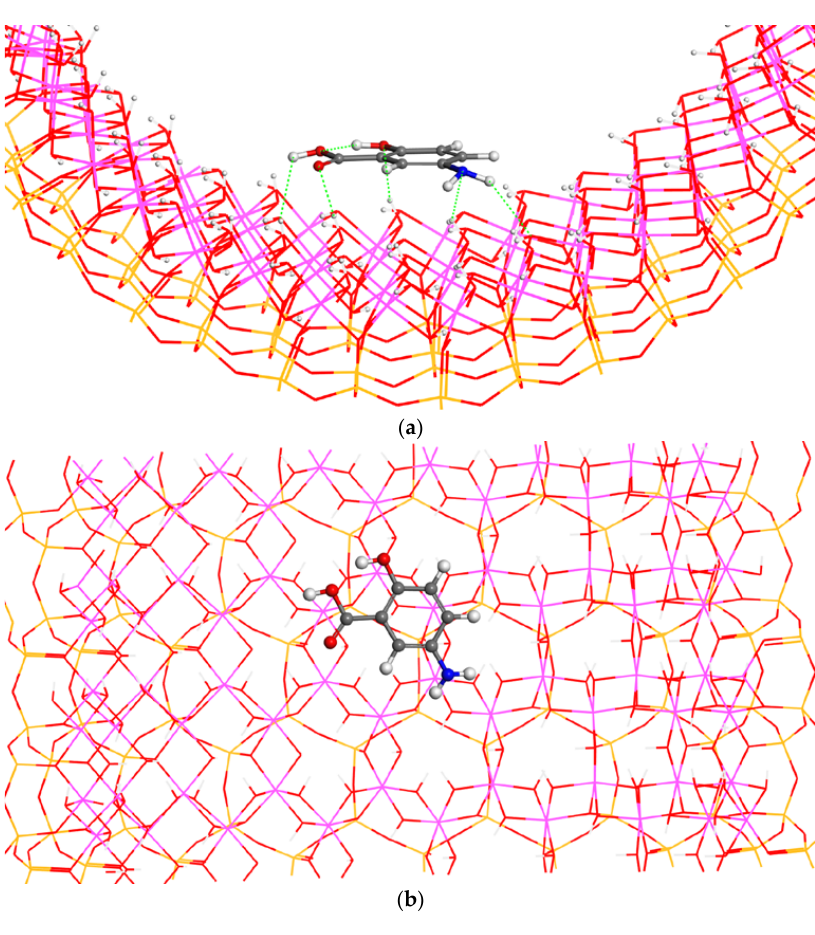
Figure 4. Optimized structure of the adsorption complex for the conformer F1 of 5-ASA placed parallel to the mineral surface and oriented parallel along the c axis of the halloysite nanotube. Views from the (001) ( a ) and (010) ( b ) crystallographic planes.